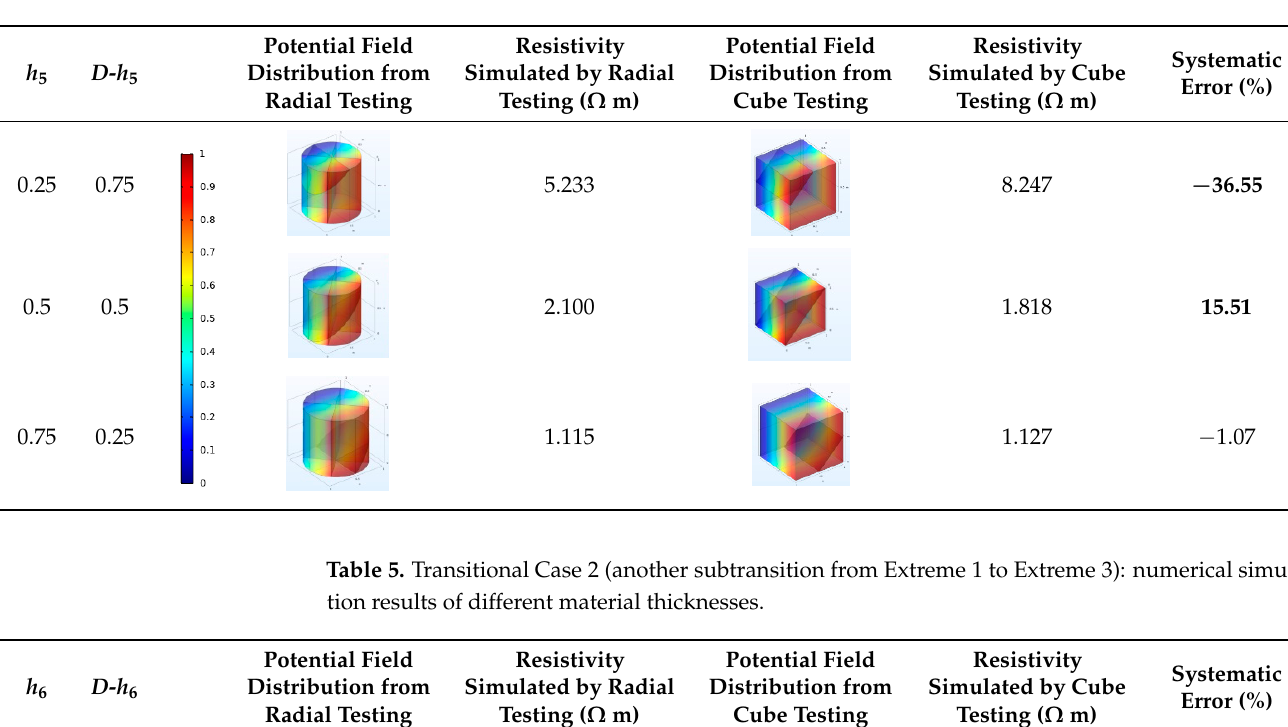
Table 4. Transitional Case 2 (one subtransition from Extreme 1 to Extreme 2): numerical simulation results of different material thicknesses.